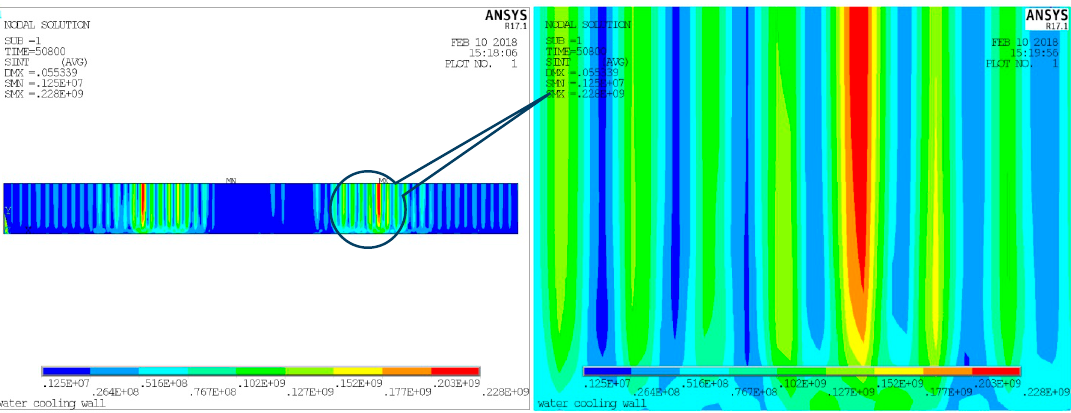
Figure 12. Shear stress contours along the front wall.